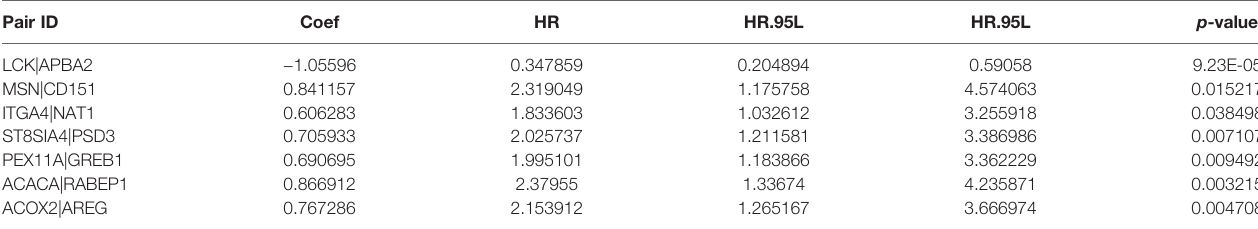
TABLE 1 | The seven pairs of DECIRGs that were used to build the risk score